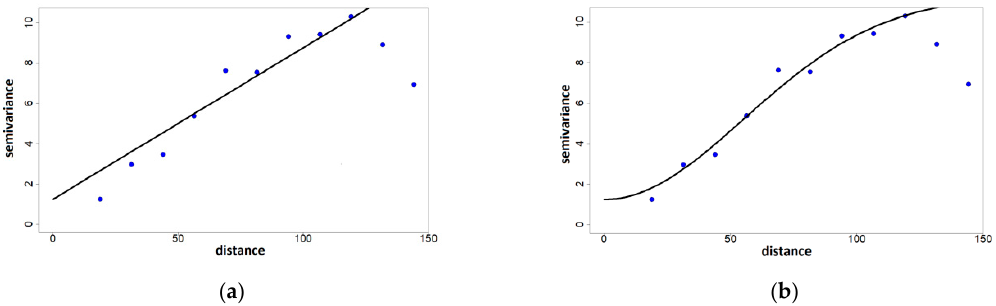
Figure A1. ( a ) the empirical semivariogram (points) and the linear semivariogram model (lines) chosen by using the xvalid function; ( b ) the empirical semivariogram (points) and the Gaussian semivariogram model (lines) chosen by using criterion 6.